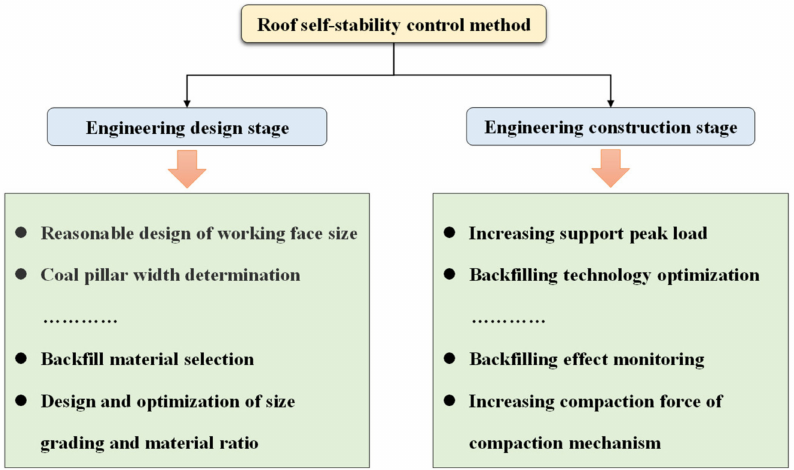
Figure 10. Roof self-stability control